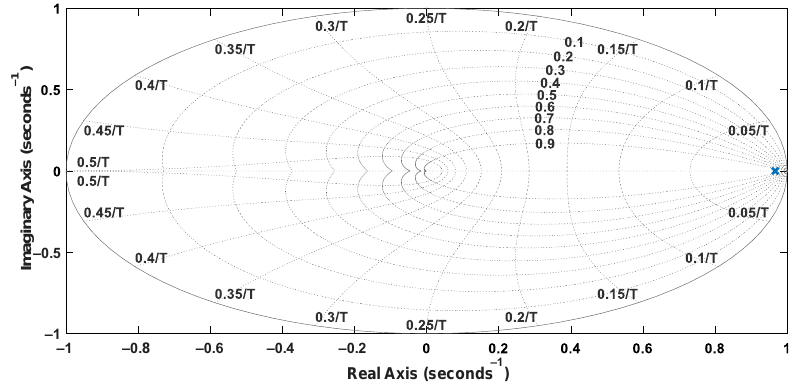
Figure 5. Pole-zero map of the ARX model.